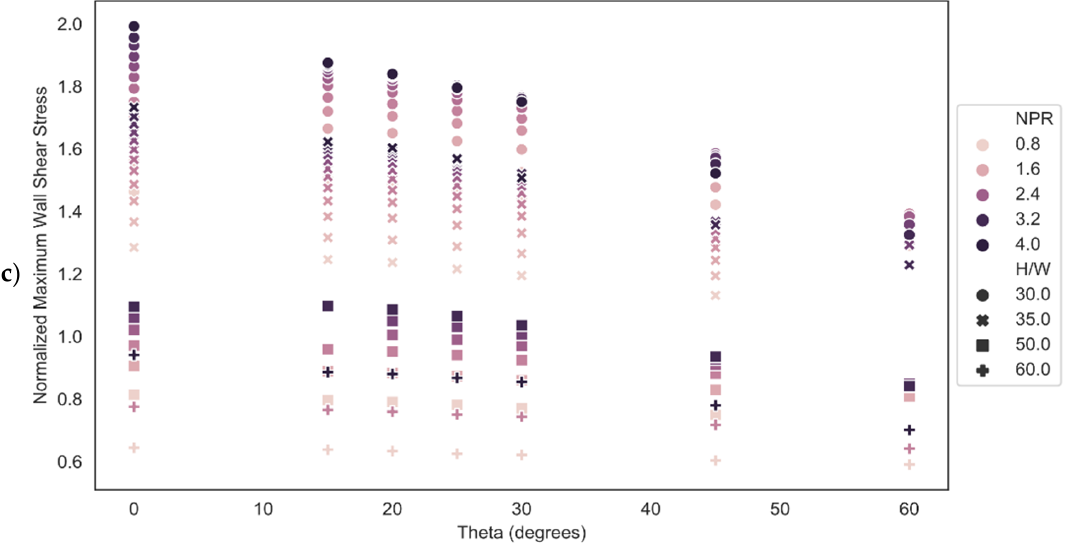
Figure 4. Normalized maximum wall shear stress plotted against Nozzle parameters with impinge- ment angle represented by shade and height to width ratio designated by the symbol ( a ) nozzle pressure ratio, ( b ) height-to-width ratio, ( c ) impingement angle.